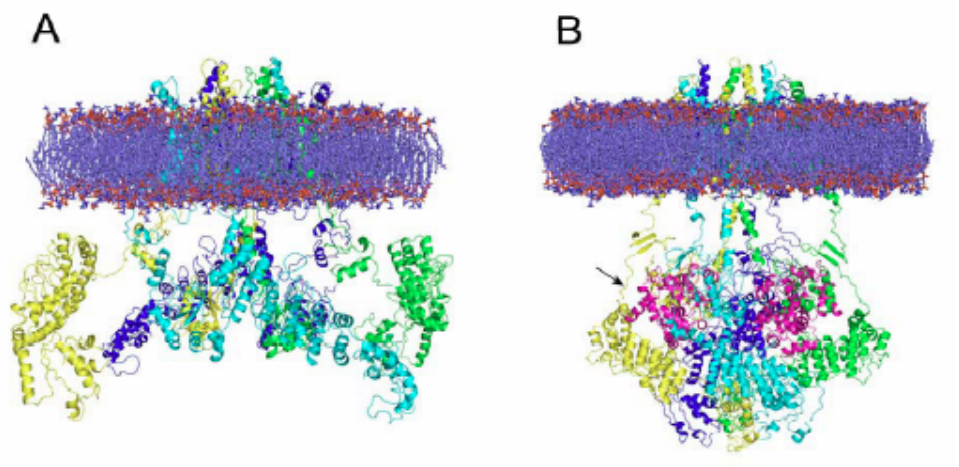
Figure 1. Tetrameric arrangement of the full human TRPV1 inserted into a model membrane. (A) Ribbon side view of the structural model of TRPV1 channel in the closed state. The extracellular loops, transmembrane and cytosolic regions (N- and C- terminus) are clearly depicted. In the closed state, the N-terminus does not interact with the C-terminus. (B) Side view of TRPV1 in the putative desensitized state. The flexibility of the N-terminal linker (black arrow) allows high mobility for the entire N-terminal to interact with the C-terminal via calmodulin (magenta)